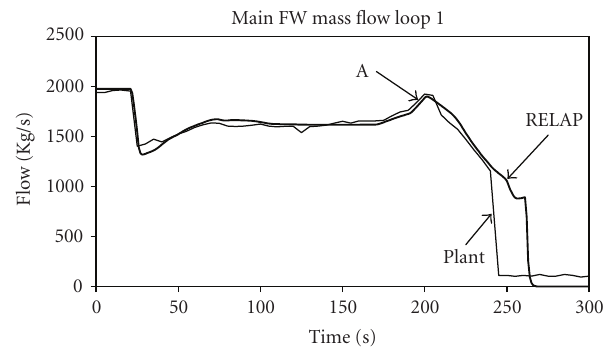
Figure 6: Main FW mass flow loop 1 (FW turbo-pump actual tran- sient).